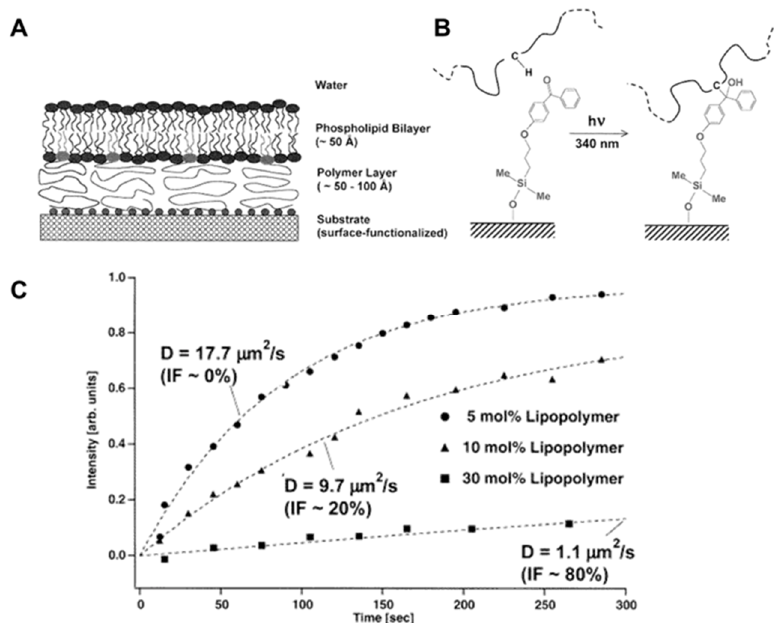
Figure 11. ( A ) Schematic illustration of the polymer-tethered phospholipid bilayer. ( B )